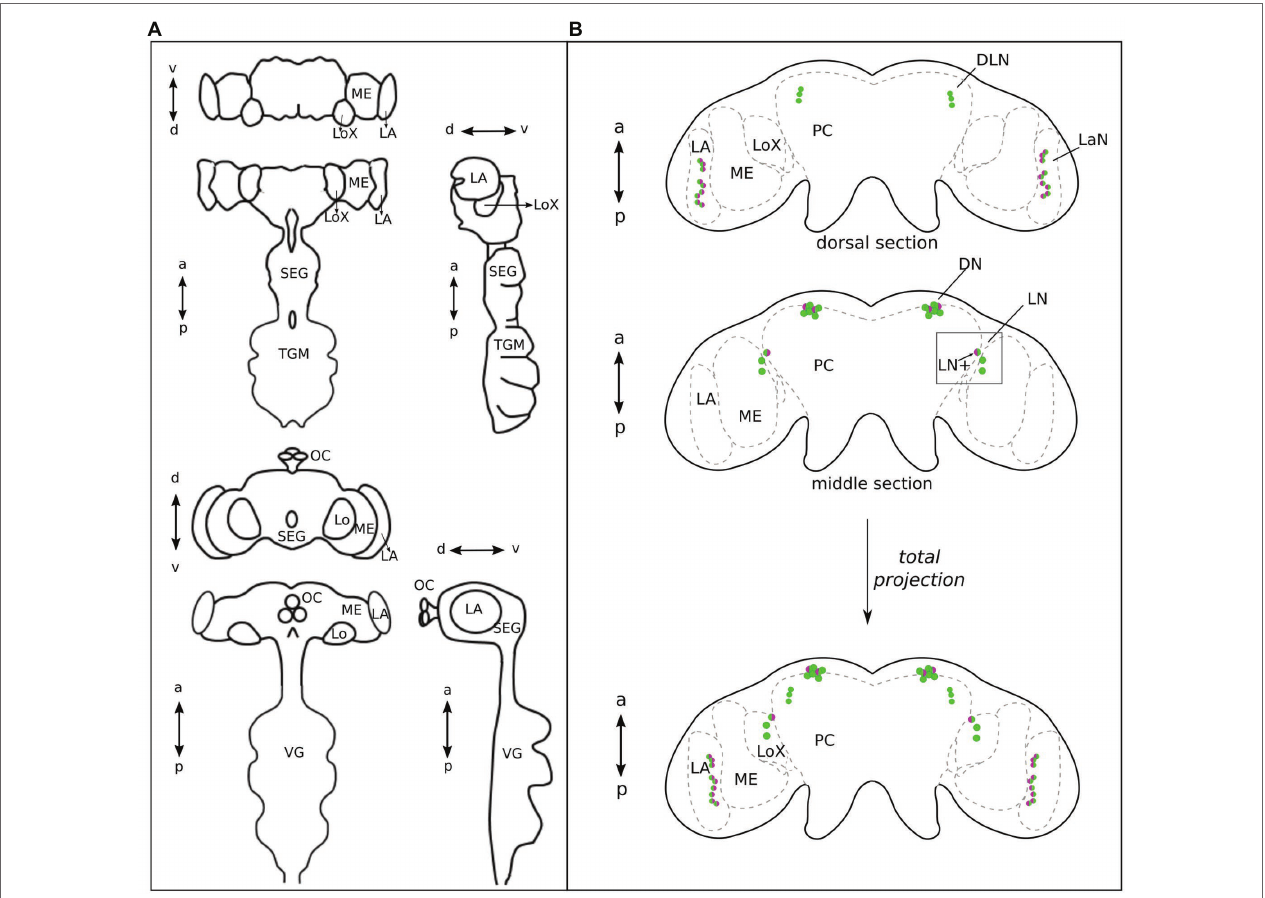
FIGURE 4 | The central brain of Aphids lays on the same plane as the ventral ganglia, while in Drosophila it almost forms a 90 ° angle with the ventral ganglia. (A) Aphid and Drosophila brains, in the upper and lower part of the panel, respectively, are shown in frontal, dorsal, and lateral views, respectively. This explains why the dorsal view of the aphid brain corresponds to the frontal view of the Drosophila brain, in the organizations of the main neuropiles. (B) Green, PER-positive neurons and magenta, CRY-positive neurons. The aphid brain in the dorsal view is divided into two sections: anterior and middle. The ventral section is not shown because no clock neurons are present. At the bottom, the total projection of the two sections is shown. The DN cluster is located most anteriorly, while the LaN cluster is most posterior. On the other hand, the DLN cluster is most dorsal and the LN cluster together with the LaN cluster most ventral. a, anterior; p, posterior; d, dorsal; v, ventral; LN+, lateral neuron expressing PER and CRY; ME, Medulla; LoX, Lobula complex; LA, lamina; SEG, Subesophageal ganglion; TGM, Thoracic ganglionic mass; and VG, Ventral Ganglia of Drosophila that correspond to the TGM of